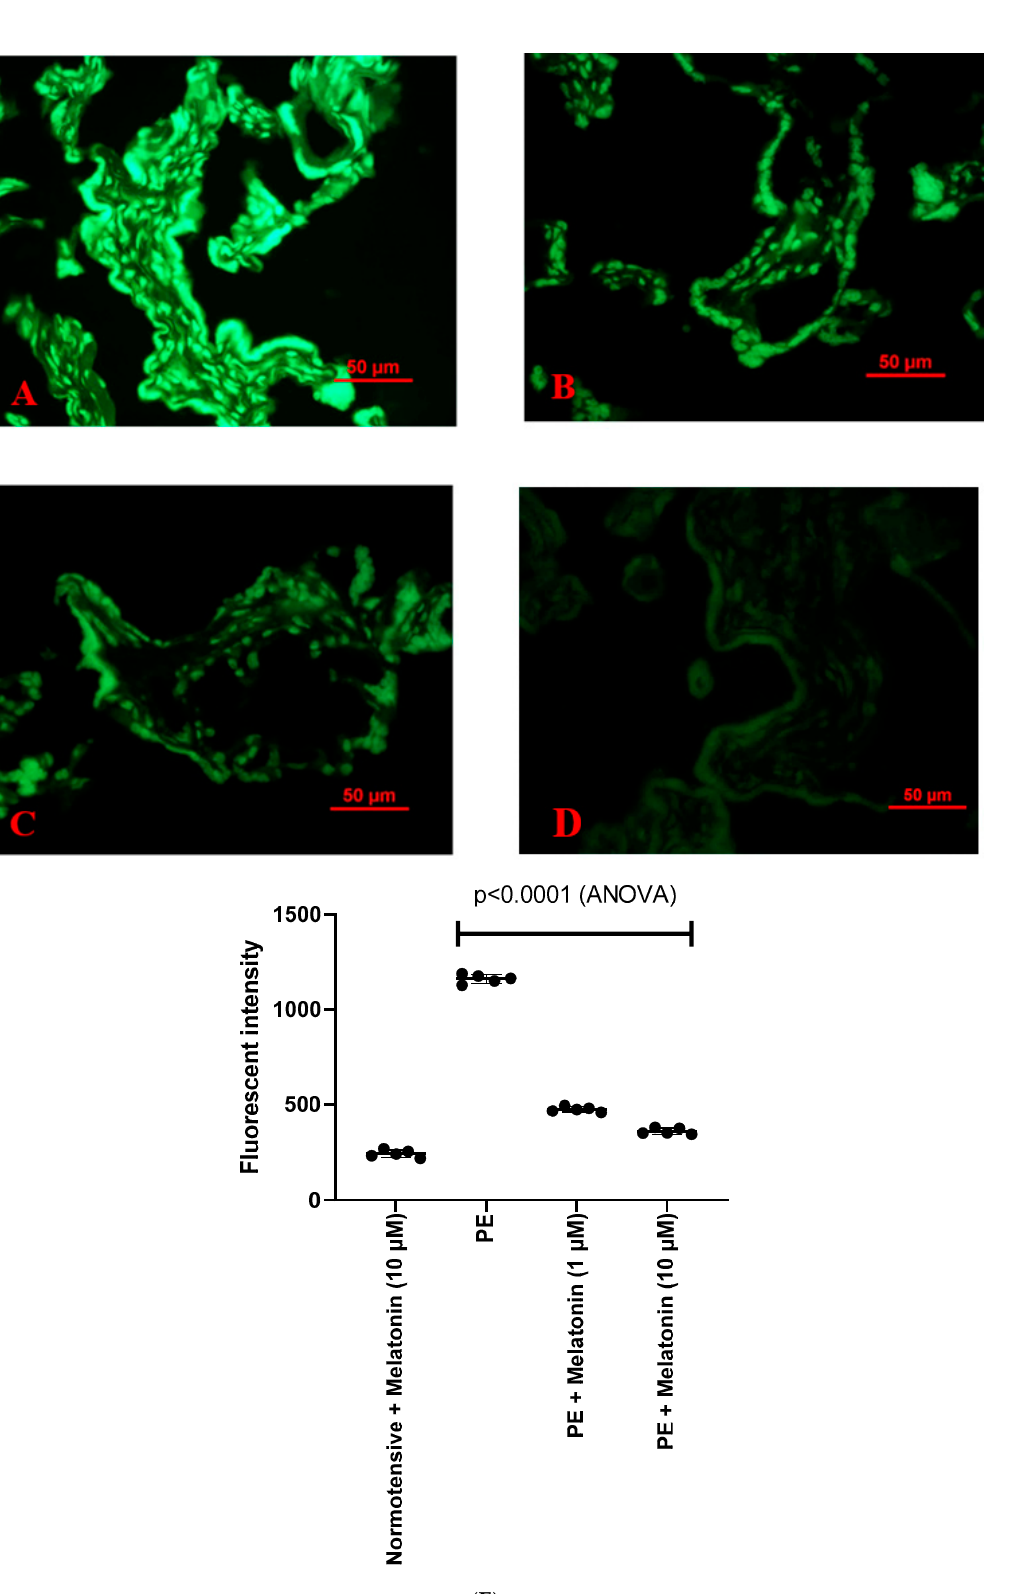
Figure 5. Misfolded proteins in preeclamptic placental explants (PE) that had been treated with 1 µ M ( B ) or 10 µ M ( C ) melatonin or without melatonin ( A ) were measured by the fluorescent intensity of ThT. In comparison, misfold proteins in normotensive placental explants that had been treated with 10 µ M ( D ) were also measured. The statistical difference was confirmed by a semi-quantitative assessment and assessed by an ANOVA test ( E